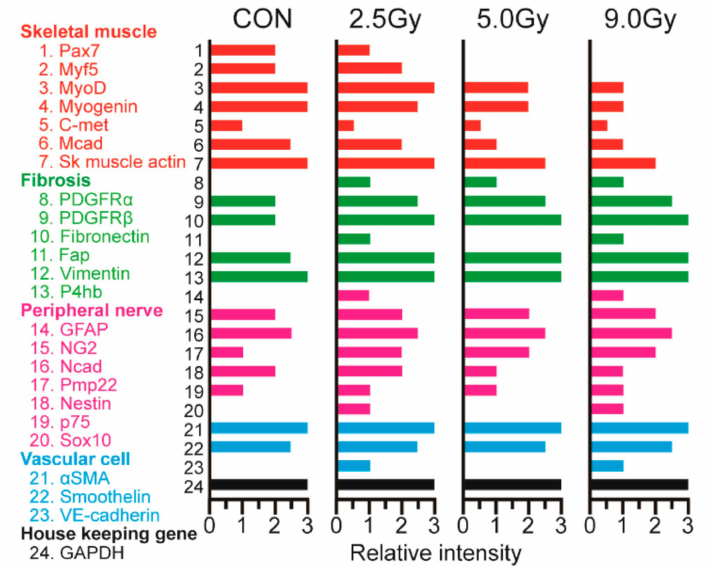
Figure 5. Relative expression of myogenic (red; 1–7), fibrosis-related (green; 8–13), peripheral nerve- related (pink; 14–20), and vasculogenic (blue; 21–23) mRNAs in bulk cells. The relative expression of these markers was determined by the strength of the band on 25, 28, and 30 graded PCR cycles, based on the housekeeping